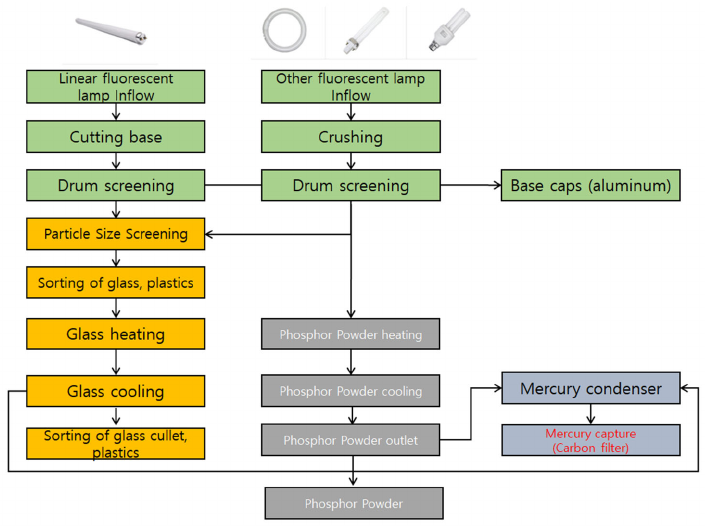
Figure 4. Recycling process of a fluorescent lamp recycling facility in South Korea.